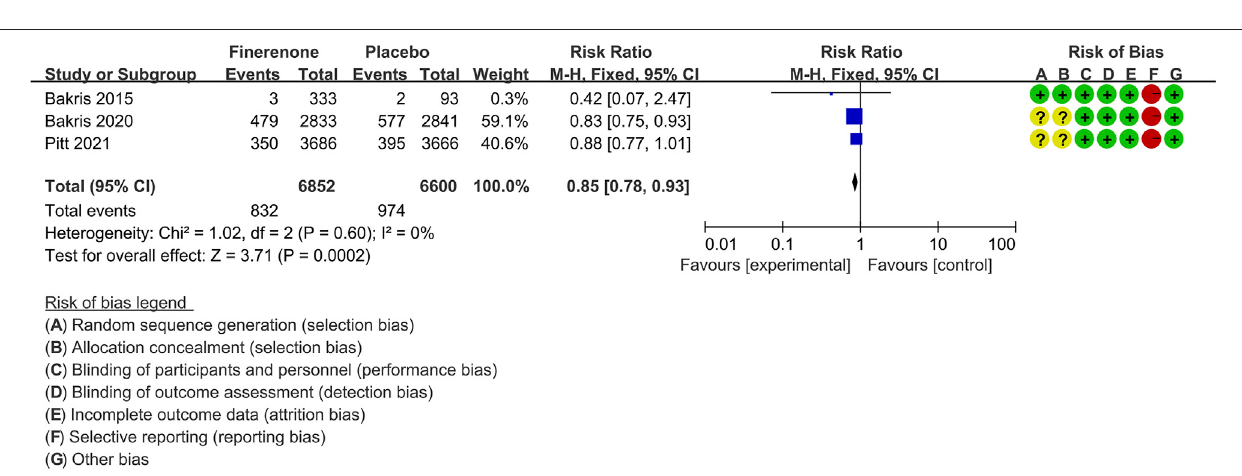
FIGURE 5 | Meta-analysis results of the proportion of patients with ≥ 40% decrease in the eGFR in fi nerenone versus placebo patient groups.